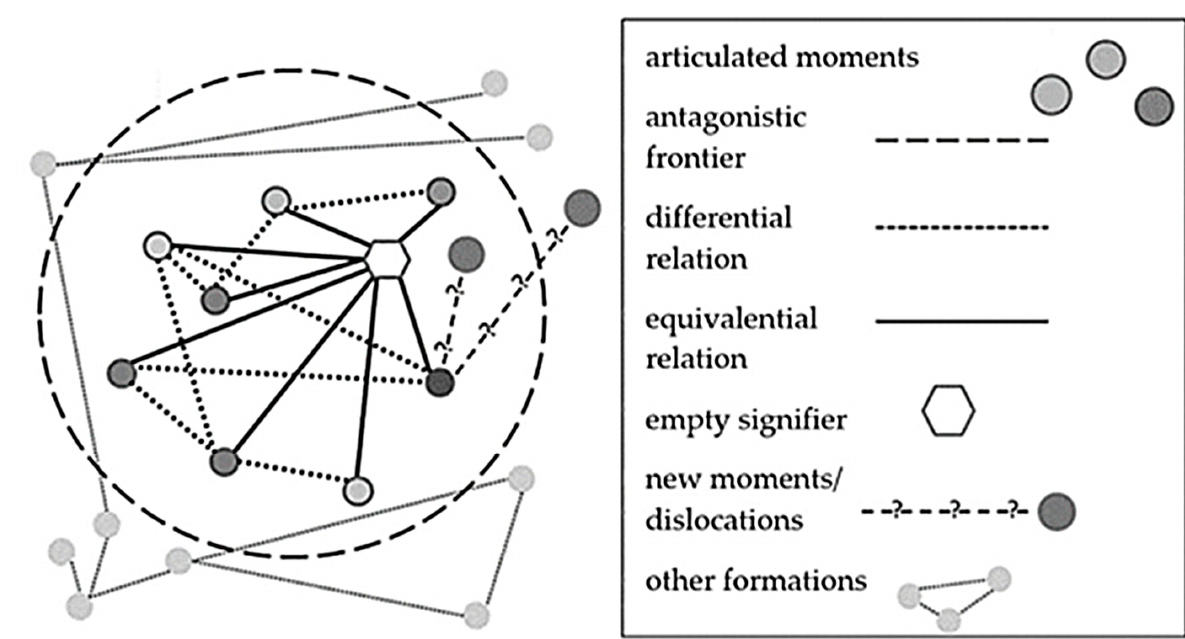
Figure 2. Simplified illustration of a dislocated discursive formation (own